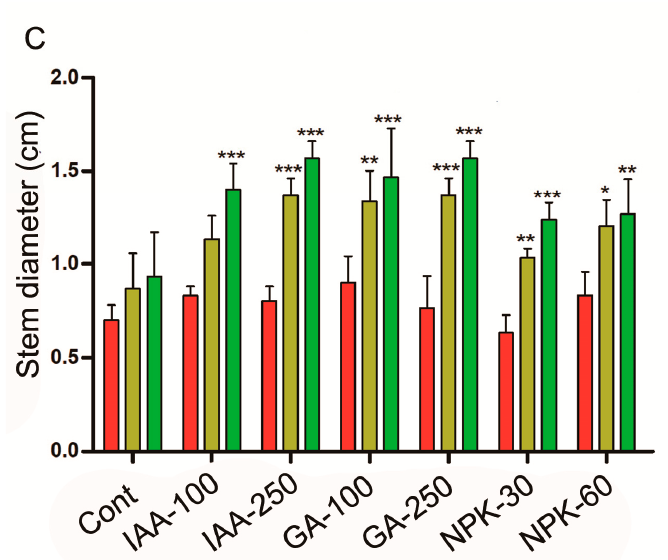
Figure 2. IAA, GA, and NPK regulate J. curcas leaves number, branches number, and stem diameter. ( A ) represents leaves number, ( B ) represents branches number, ( C ) represents stem diameter. Graphs show mean ± standard deviation, and asterisks show significant differences (* p ≤ 0.05, ** p ≤ 0.01, and *** p ≤ 0.001) according to two-way ANOVA and Bonferroni post hoc